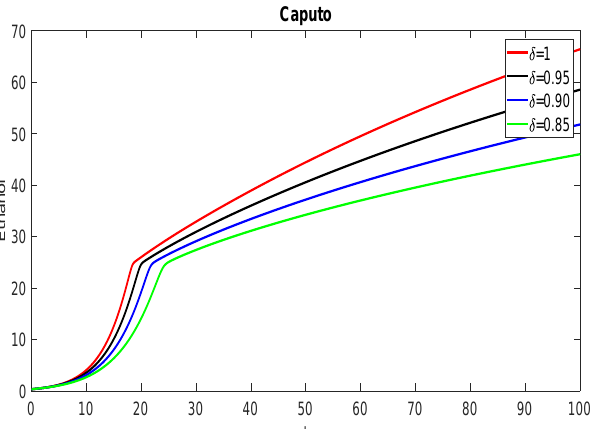
Figure 1. Evolution of the substrate, biomass and ethanol for fractal dimension 0.8 and different fractional orders in Caputo sense.